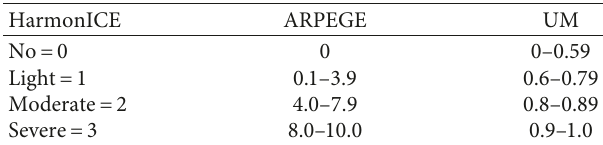
Table 1: Thresholds used for the transformation of the original icing index potential based on ARPEGE and UM to the four-step range used in